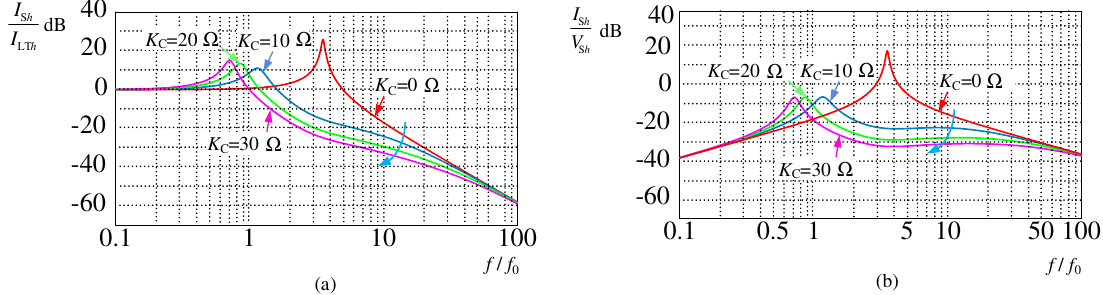
Figure 6. Gain plots for Figure 5. ( a ) Gain plots for Figure 5c. ( b ) Gain plots for Figure